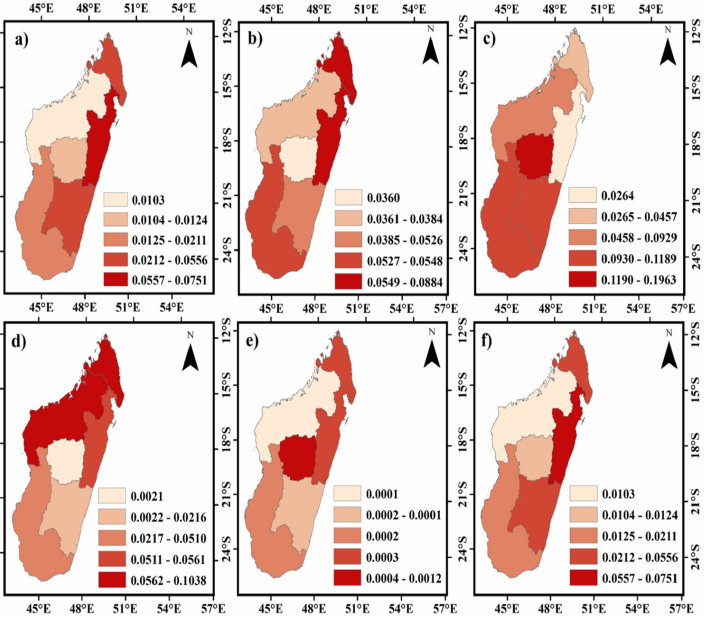
Figure 6. Spatial pattern of sensitivity coefficients of different land ‐ use types of provinces in Mada ‐ gascar island in 2019. Important factors were ( a ) the spatial pattern of the sensitivity coefficient of cultivated land; ( b ) the spatial pattern of the sensitivity coefficient of forestland; ( c ) the spatial pat ‐ tern of the sensitivity coefficient of the savannah; ( d ) the spatial pattern of the sensitivity coefficient of wetland; ( e ) the spatial pattern of the sensitivity coefficient of built up; ( f ) the spatial pattern of the sensitivity coefficient of water. On the town scale, the sensitivity coefficient of cultivated land was higher in Sam ‐ bava, Ambatondrazaka, and Tsihombe Towns (Figure 7a). In contrast, for forest and sa ‐ vannah, the sensitivity coefficient was relatively higher in Mandritsara, Ambalavao, Ta ‐ nanarivo, Mahabo, Ampanihy ‐ Oeust, and Toliary II towns (Figure 7b,c). Both the wetland and water area sensitivity coefficients were much higher in Ambilobe, Ambanja, Nosy be hell ville, and Mitsinjo towns (Figure 7d,f). Antananarivo was the most common location with significantly higher built ‐ up land sensitivity indexes.